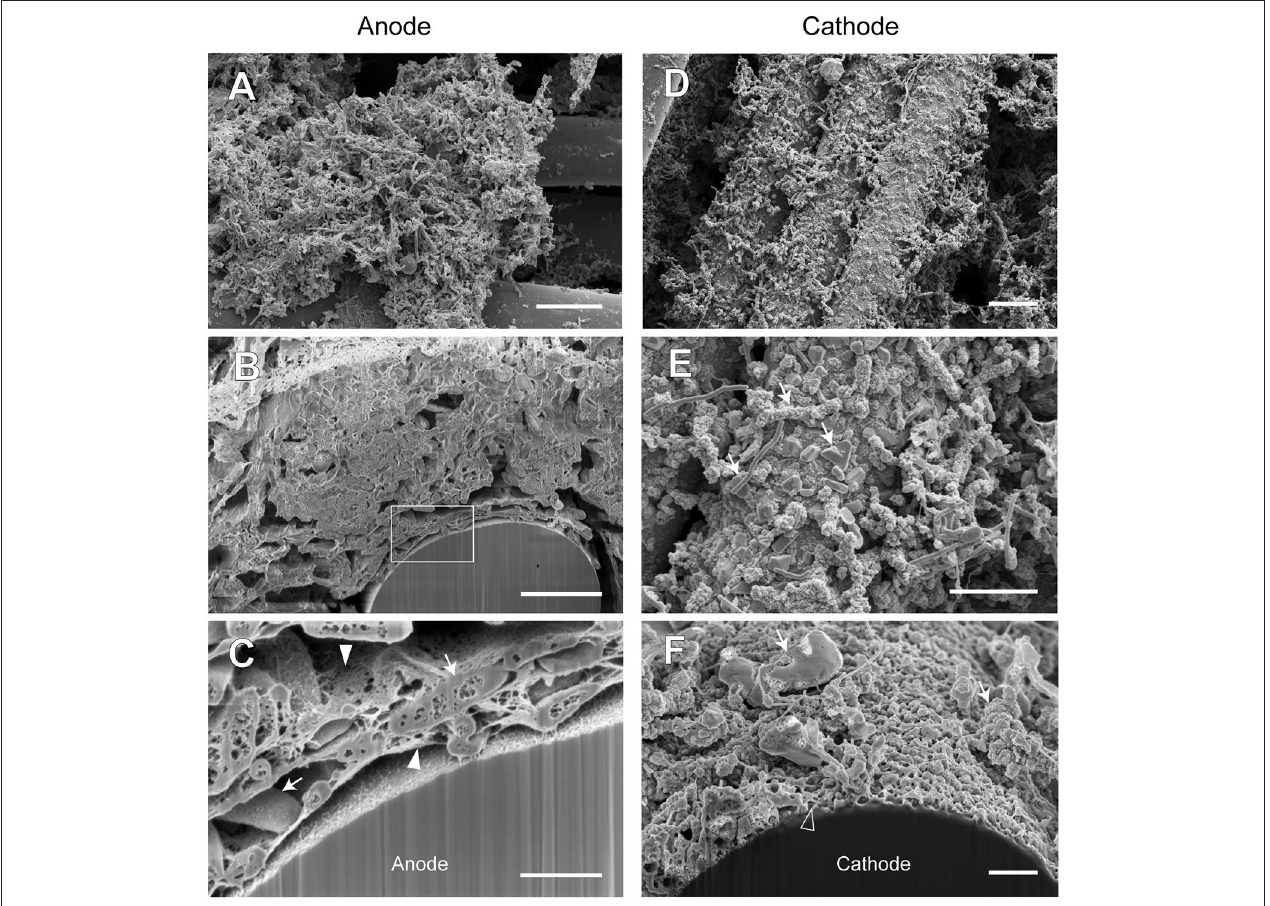
FIGURE 9 | FE-SEM images for anode and cathode biofilms adhering onto carbon cloth electrodes in the electromethanogenic BES reactor A. Anode (A–C) and cathode (D–F) samples were collected from BES reactor A after 19-month enrichment process. B,C,F are cross-section images of biofilms that were processed by a focused ion beam, and (C) shows a magnified image near electrode [rectangle region in (B) ]. Arrows in (C,E,F) indicate microbes close to the electrodes. Filled arrowheads in (C) indicate filamentous mat structures in the anode biofilm, while open arrowhead in (F) indicates mesh-patterned structure in the cathode surface. Bars (A,D) = 10 µ m. Bars (B,E) = 5 µ m. Bars (C,F) = 1 µ